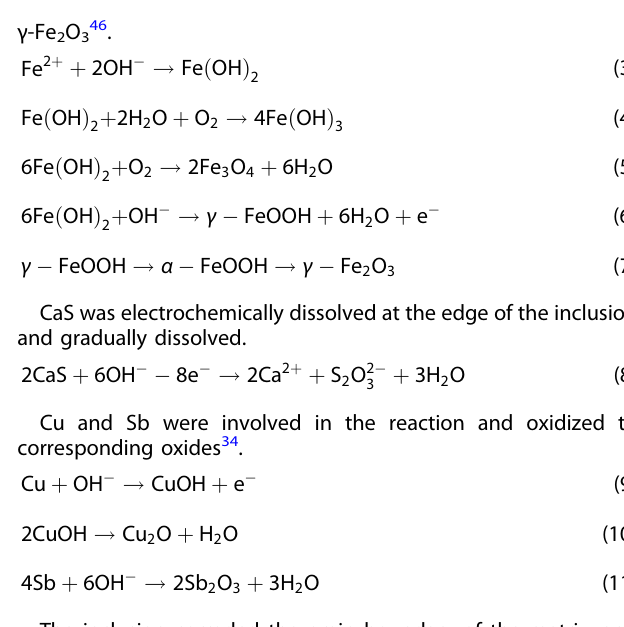
Fig. 8 The characteristics of Ni and Sb capture by Cu in Cu-containing inclusions. a Distribution characteristics of corrosion-resistant elements at the boundary of inclusion and matrix. b Elemental content of Ni and Sb in different Cu precipitation phases and matrix